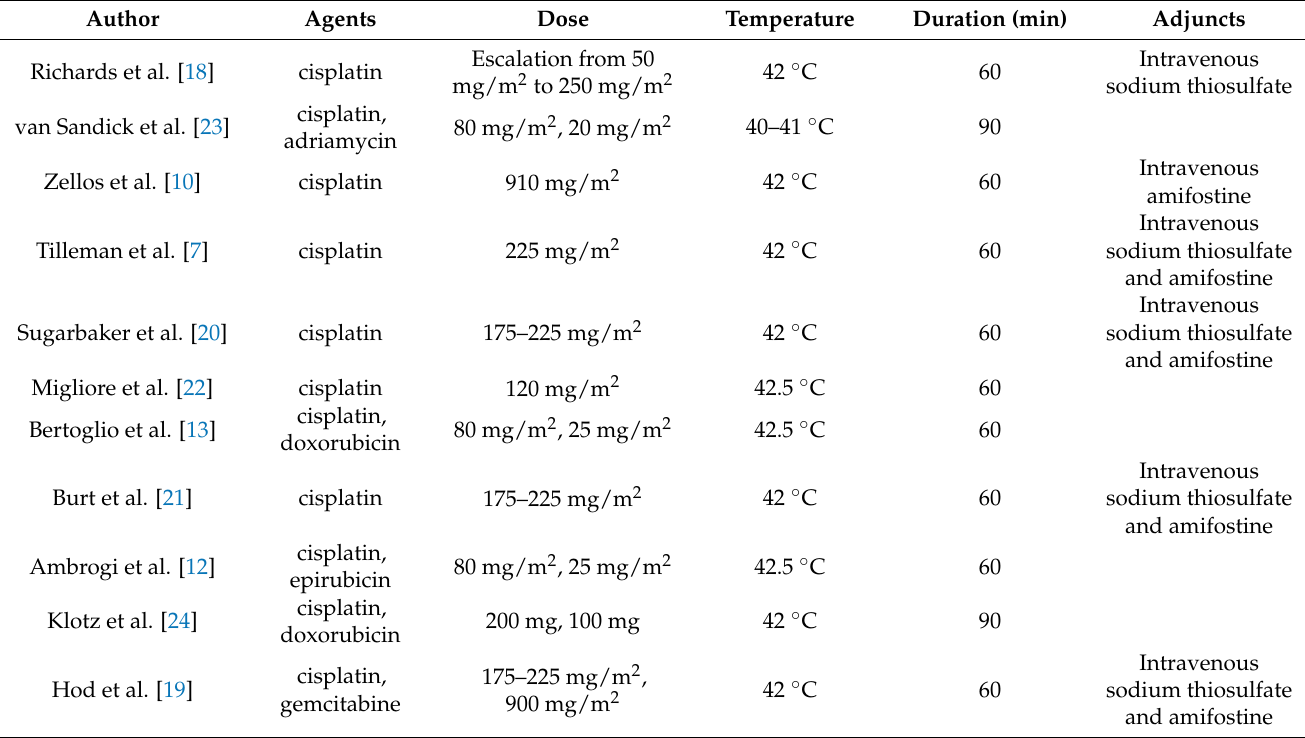
Table 2. Details of hyperthermic intrathoracic chemotherapies